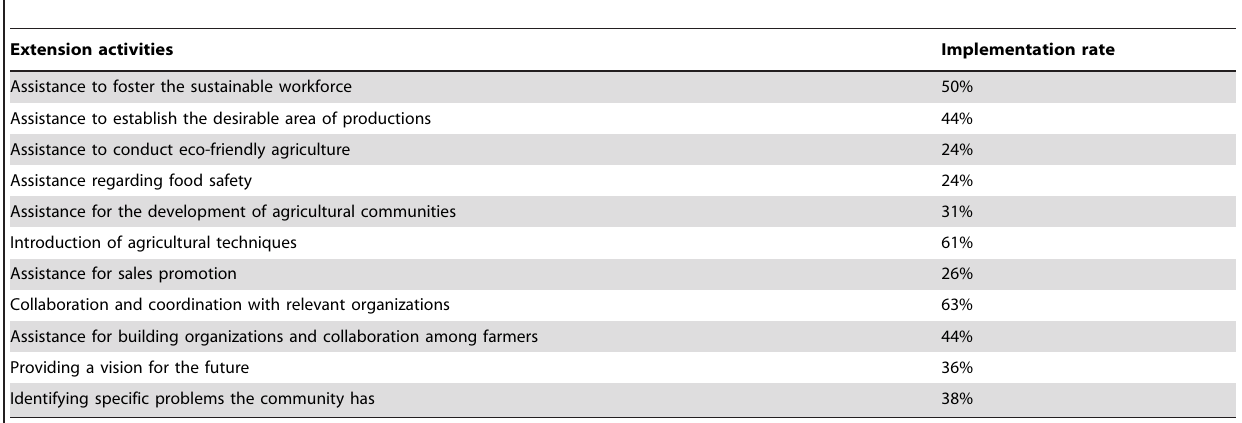
Table 2. Extension activities and implementation rate in difficult situations respondents